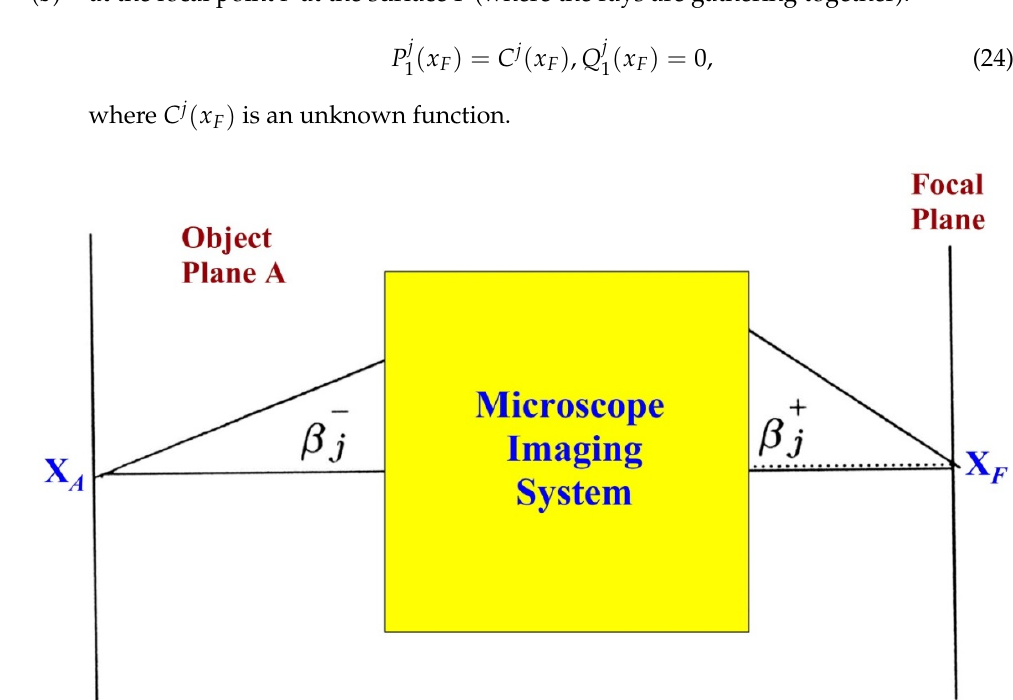
Figure 6. The model of a microscope system without spherical aberration.